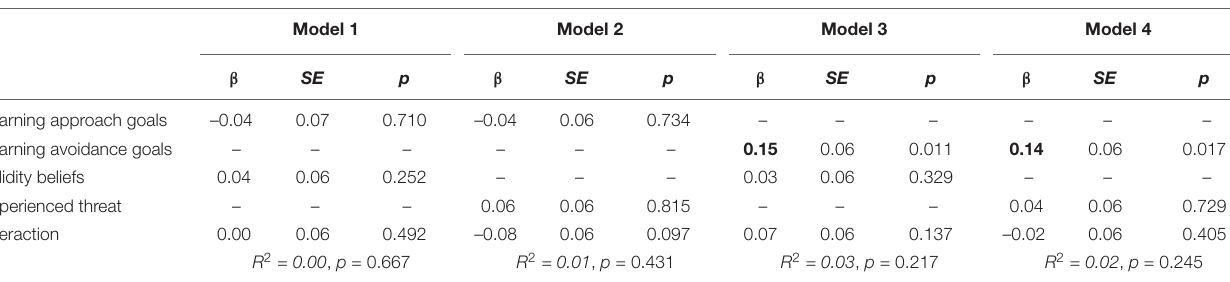
TABLE 3 | Results of the manifest moderation